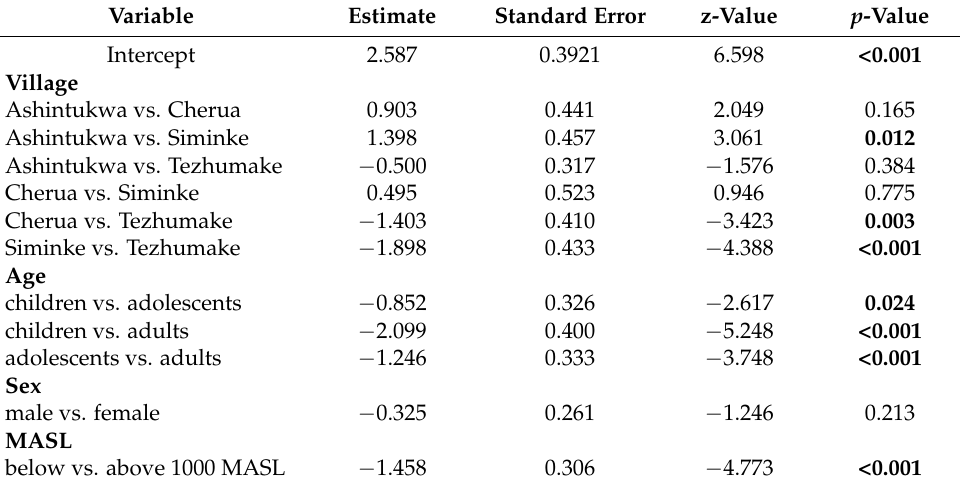
Table 2. Results from the general linear model (GLM) testing the effect of different variables on the Toxocara seroprevalence in the North Colombian indigenous tribe of the Wiwa ( n = 483). The final model was significantly different from a null model containing only an intercept term (likelihood ratio test, df = 6, χ 2 = 58.643, p < 0.001). Significant p -values are printed in